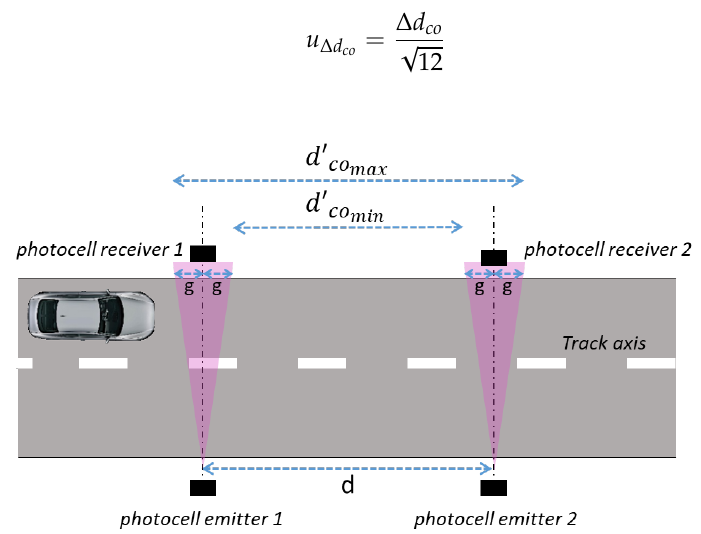
Figure 6. Uncertainty contribution due to the not collimated laser beam.